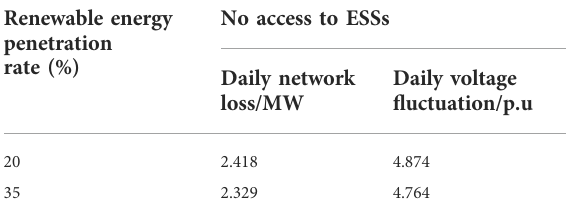
TABLE 8 Network loss and voltage fl uctuation when ESSs is not con fi gured. Renewable energy penetration rate